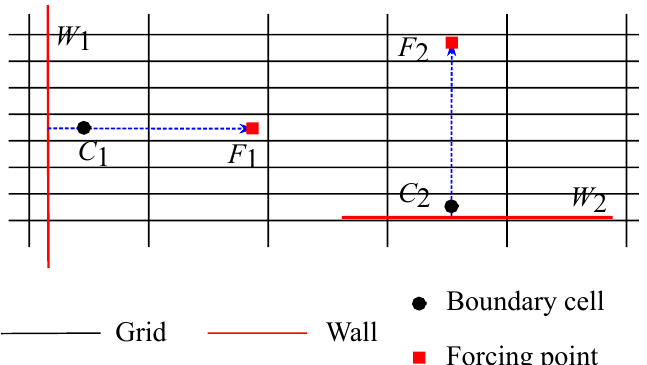
Figure 3. A same forcing distance is used for different wall